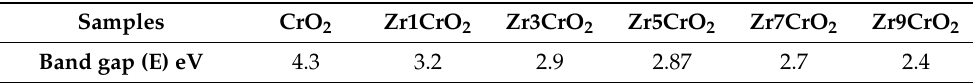
Table 2. Band gaps of synthesized Zr-doped CrO 2 photocatalysts.